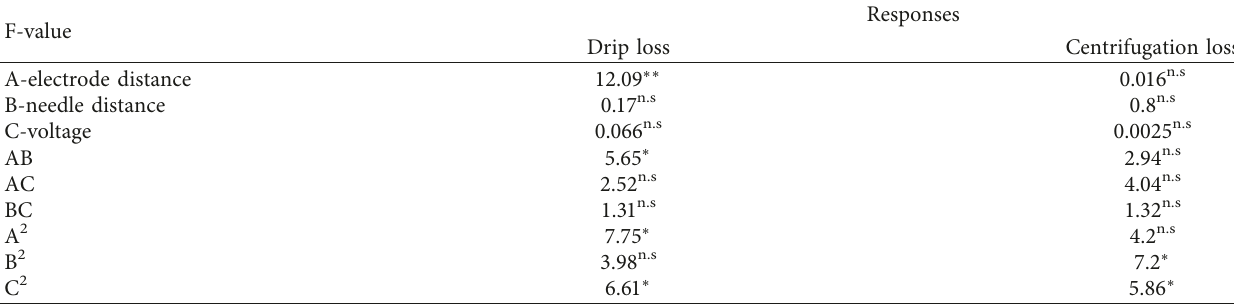
Table 4: Effect of different treatments on drip loss and centrifugation loss.